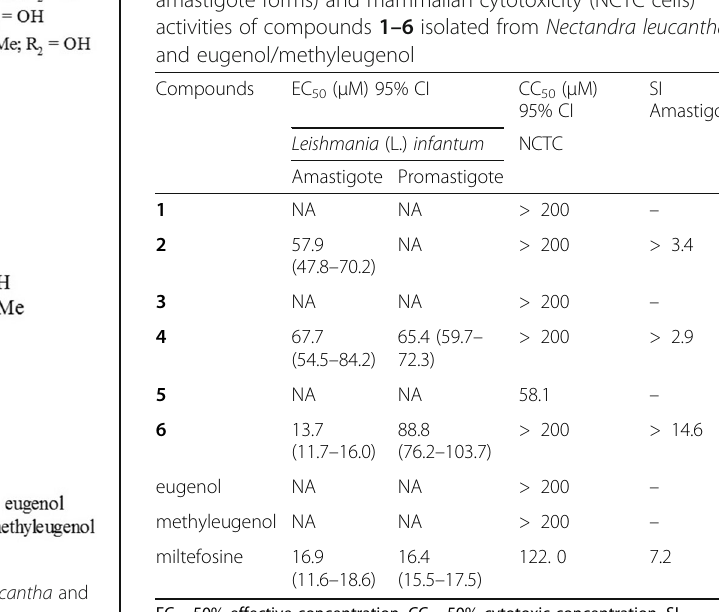
Table 1 Anti- Leishmania (L.) infantum (promastigote and amastigote forms) and mammalian cytotoxicity (NCTC